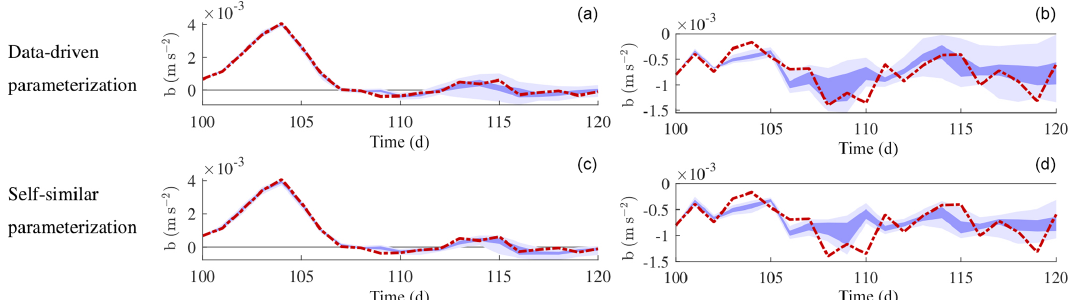
Figure 13. Confidence interval at 95% (light purple) and at 50% (dark purple) along time, computed from the low-resolution stochastic SQG 200-member ensemble with the data-driven (a, b) and with the self-similar (c, d) parameterization, at the points (500, 250km) (a, c) and (250, 500km) (b, d) . The high-resolution reference is superimposed in